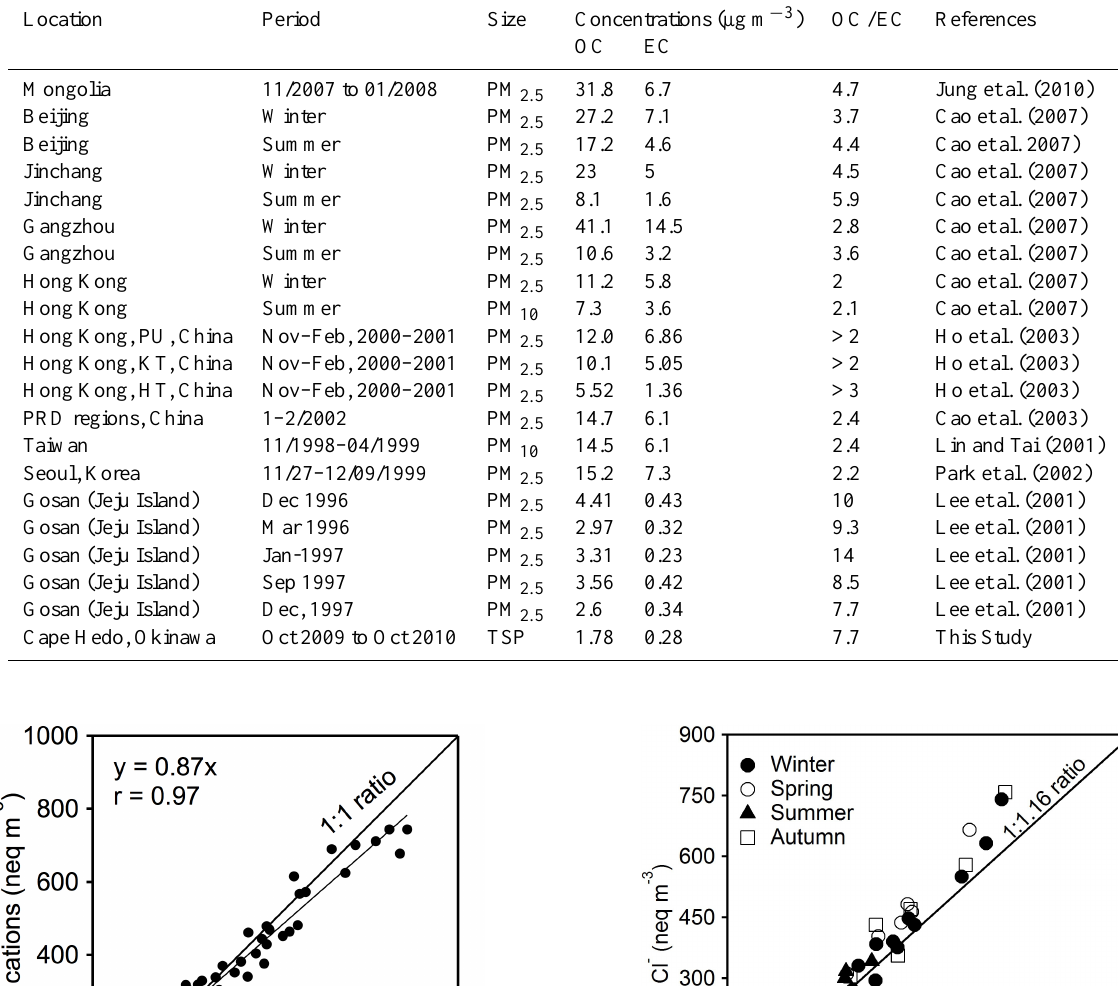
Table 3. OC and EC concentrations and OC to EC mass ratios in atmospheric aerosols from different locations in East Asia. Location